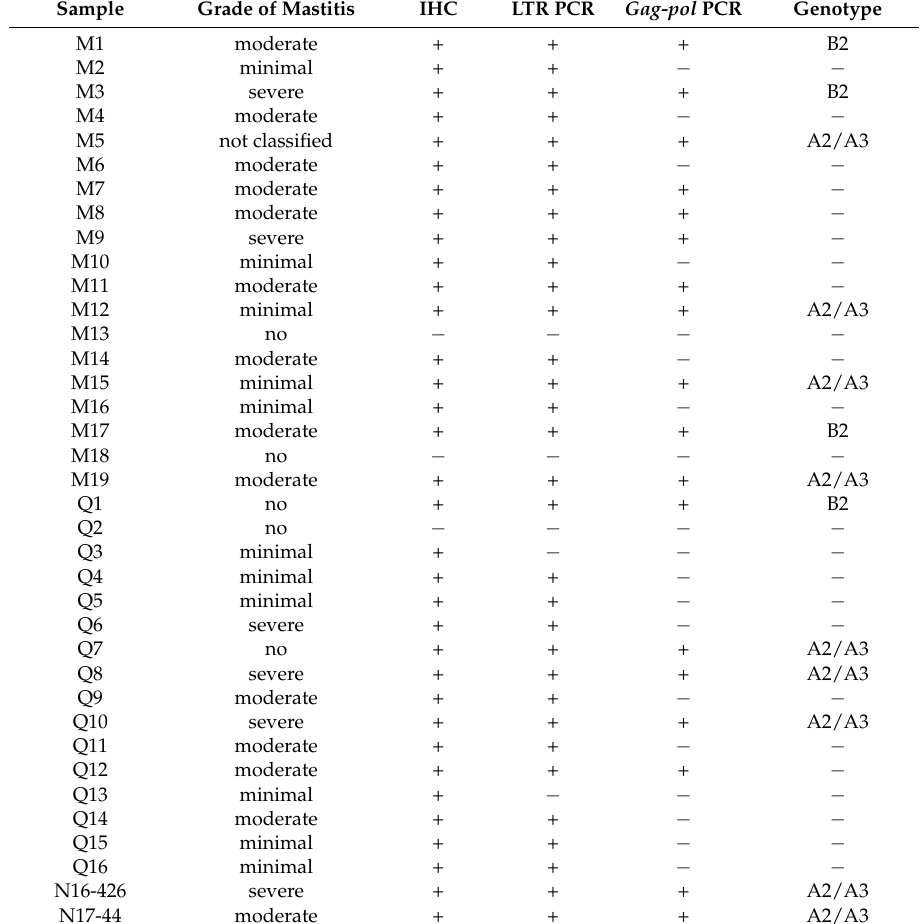
Table 1. List of ovine mammary gland samples collected for this study. Samples are classified on the basis of the grade of mastitis observed by histopathology. Lesions in sample M5 were not classified due to concomitant purulent mastitis was present. “+”: positive result, “ − ”: negative result.